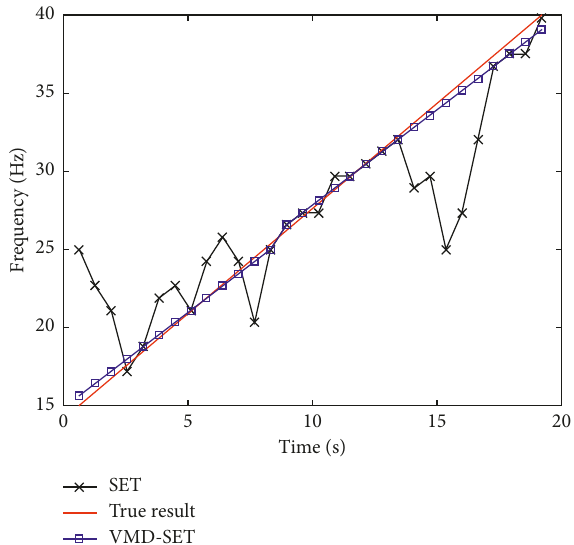
Figure 7: Comparison between estimated instantaneous frequency and true result of LFM signal.